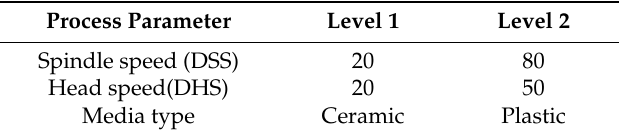
Table 5. DOE layout and drag finishing results using Taguchi